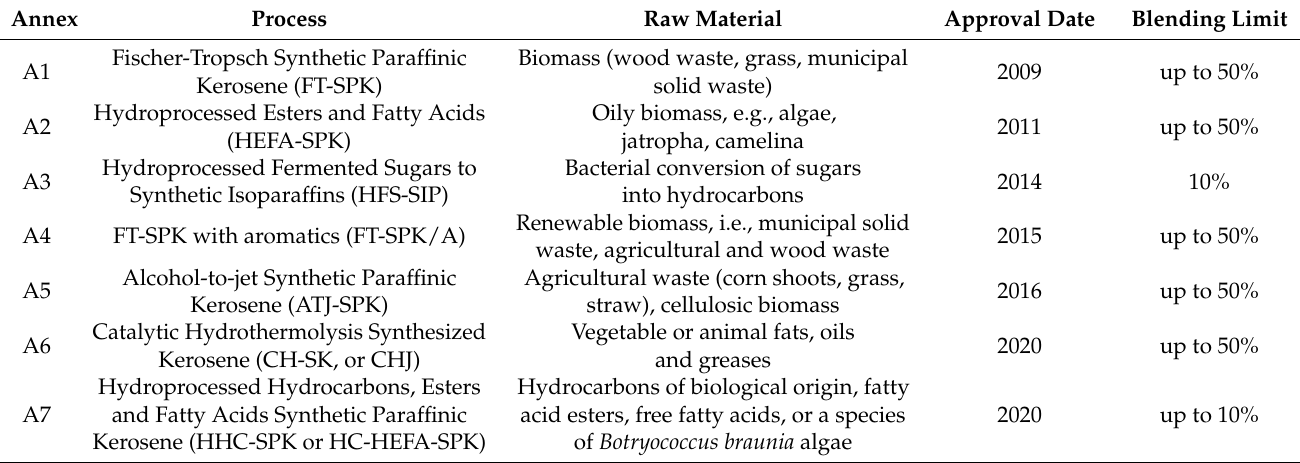
Table 2. Methods of producing alternative fuels approved by the ASTM D7566 standard (own study based on